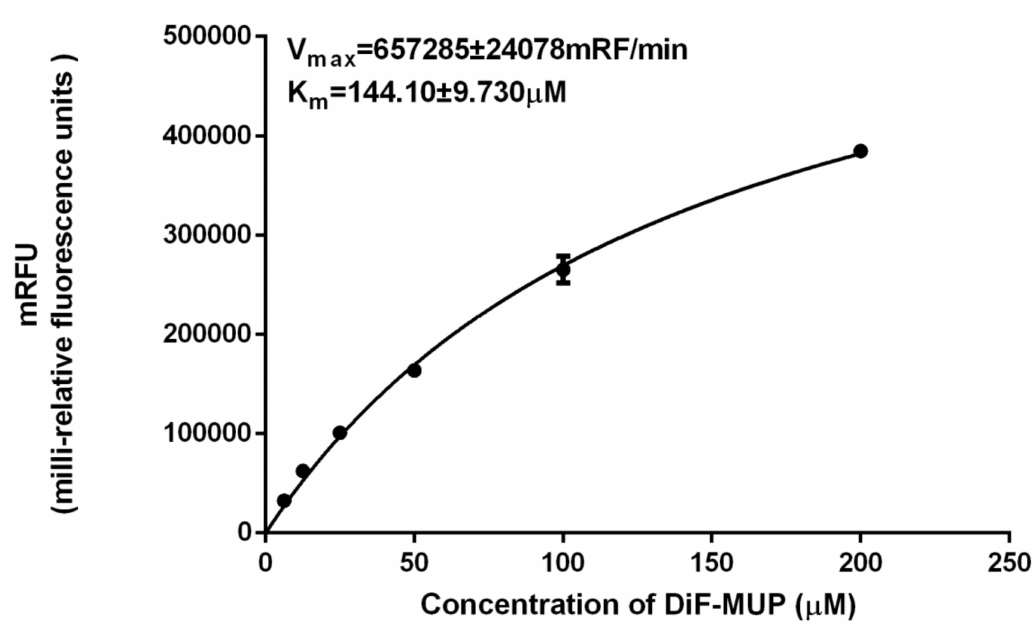
Figure 4. Kinetics of DiFMUP (6,8-difluoro-4-methylumbelliferyl phosphate) dephosphorylation by the catalytic domain of PP5 (PP5c). Data are shown as mean ± SD.